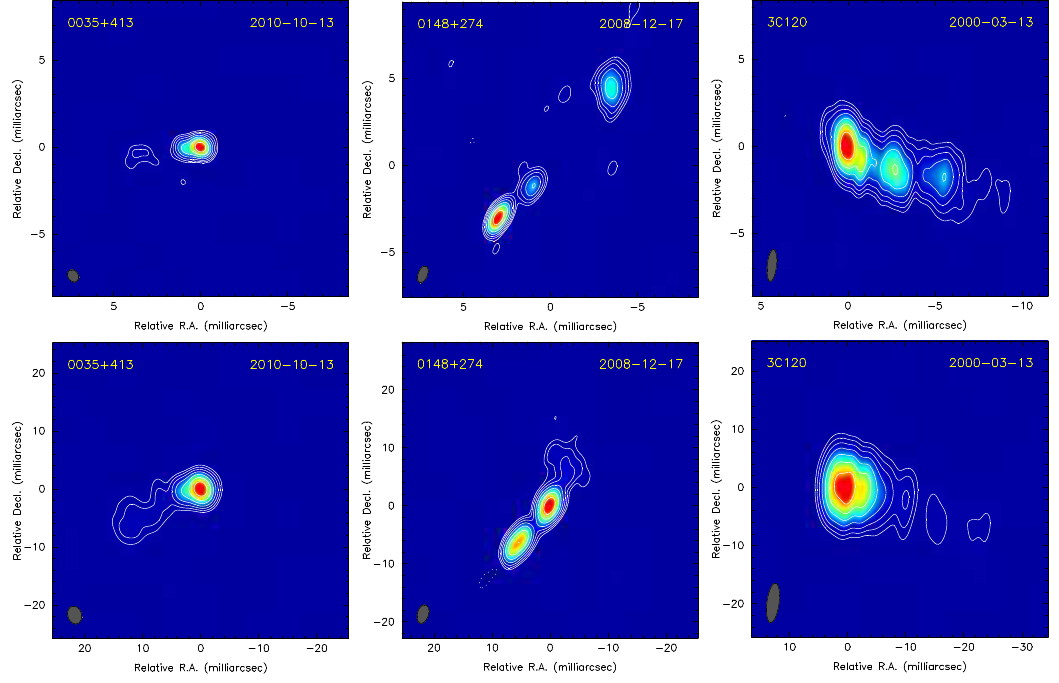
Figure 5. VLBI maps at X-band (upper sub-panels) and S-band (lower sub-panels) for three ICRF-3 non-defining sources showing single-sided jets (0035+413, 0148+274 and 0430+052). Contour levels are drawn at ± 1, 2, 4, 8, 16, 32, and 64% of the peak brightness. Note that the map scale at X-band and S-band is different. These maps are from the BVID [25]. See https://bvid.astrophy.u-bordeaux.fr/ (accessed on 13 May 2022) for full details on the map